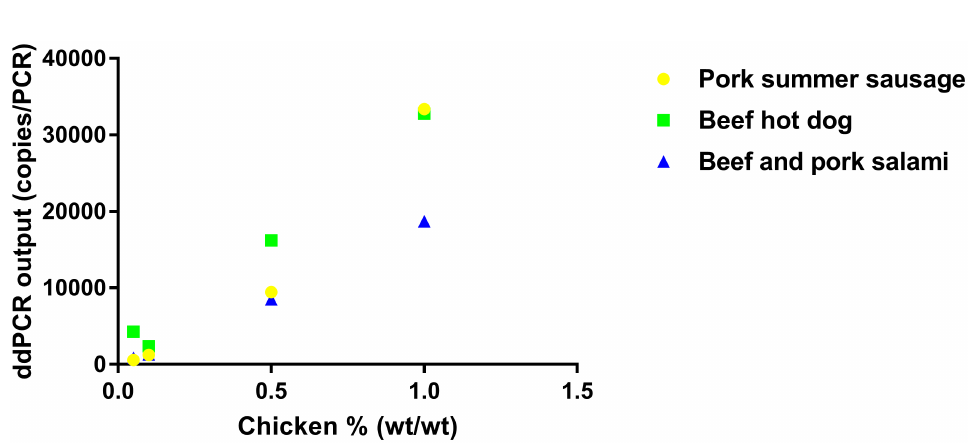
Fig 5. An example showing the effect of sample matrix on ddPCR output (copies/PCR). A cooked chicken sample was spiked in pork summer sausage,beef hot dog or beef and pork salami matrices.